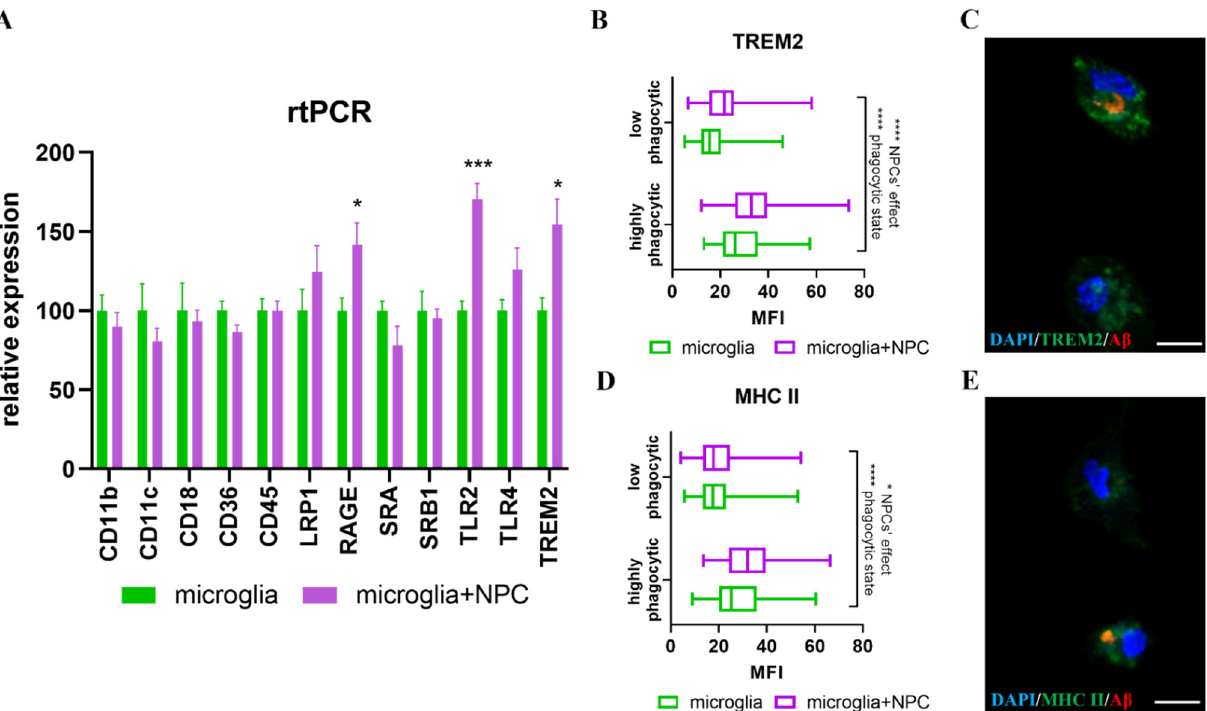
Figure 4. NPCs induce an increase in expression of genes associated with phagocytosis in microglia. ( A ) Real time PCR on RNA from microglia isolated from 7-month-old 5xFAD mice. Co-culturing with newborn-mouse-derived NPCs induced increased gene expression of RAGE (* p = 0.03), TLR2 (*** p = 0.0003) and TREM2 (* p = 0.016) in microglia. ( B ) Quantification of TREM2 staining by MFI per cell in high- and low-phagocytic microglia in the presence or absence of NPCs. Two-way ANOVA analysis showed significant factors of groups (1.2-fold increase in expression by NPCs, **** p < 0.0001) and phagocytic activity (1.5-fold higher expression in highly phagocytic microglia, **** p < 0.0001). ( C ) Representative image of TREM-2 expression in microglia with high versus low A β -phagocytic activity. ( D ) Quantification of MHC-II staining per cell by MFI in high- and low-phagocytic microglia in the presence or absence of NPCs. Two-way ANOVA analysis showed significant factors of groups (1.15-fold increase in expression by NPC in the high phagocytic group, * p < 0.0302) and phagocytic activity (1.46-fold expression in highly phagocytic microglia, **** p < 0.0001). ( E ) Representative image of MHC-II expression in microglia with high versus low A β phagocytic activity. There was no interaction between the two variables in B and D, suggesting that NPCs’ effect and the phagocytic state were independent in their effects on TREM2 and MHCII expression. MFI = mean fluorescent intensity. blue = DAPI, green = MHC-II/TREM2, red = A β , scale = 10 µ